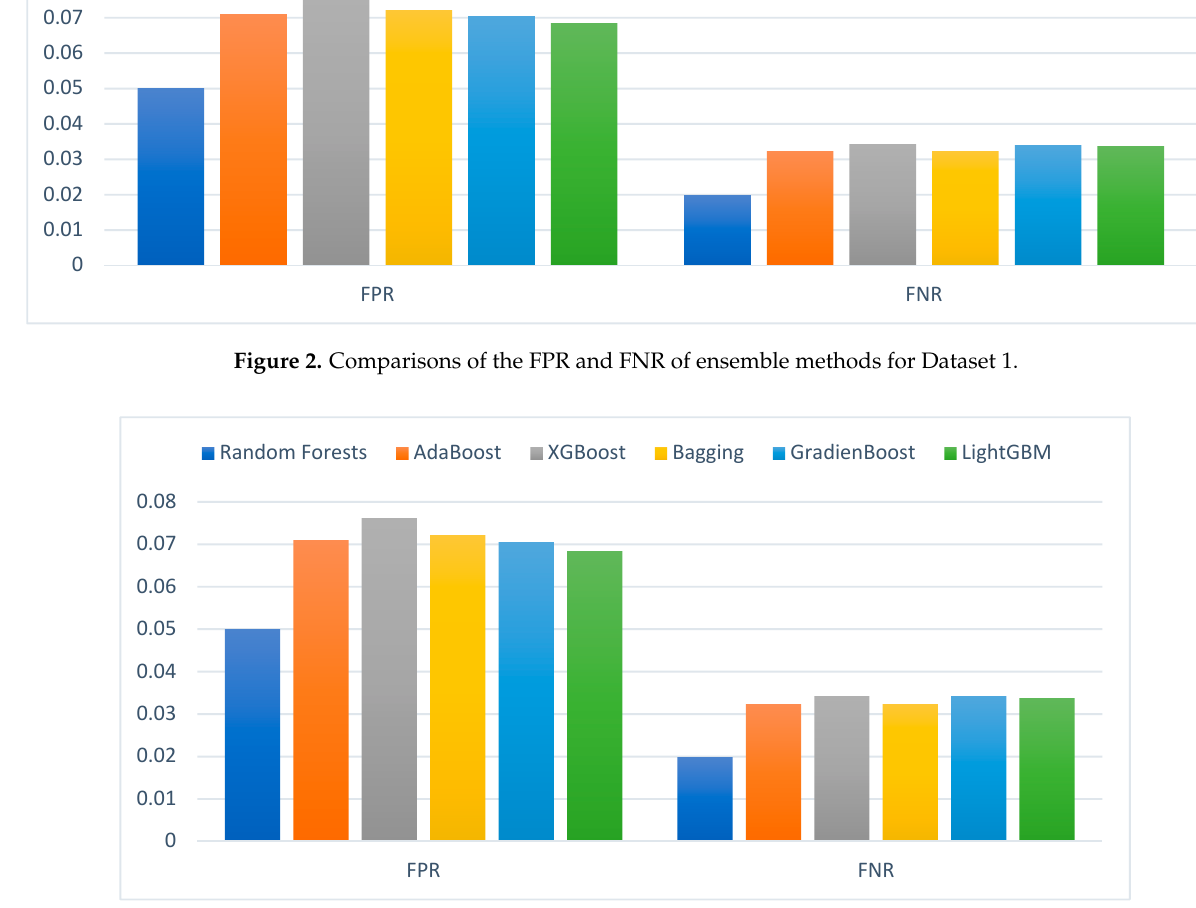
Figure 2. Comparisons of the FPR and FNR of ensemble methods for Dataset 1 . Table 3. Performance of ensemble classifiers for Dataset 2 .